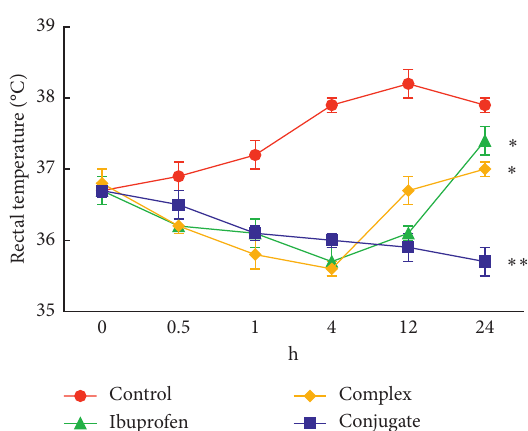
Figure 5: Effect of ibuprofen, complex, and conjugate on 30% brewer’s yeast-induced pyrexia in mice model ( n � 8). Each data represent the mean ± SEM. The asterisks denote the significance levels in comparison with the control group, ∗ P ＜ 0.05 and ∗∗∗ P ＜